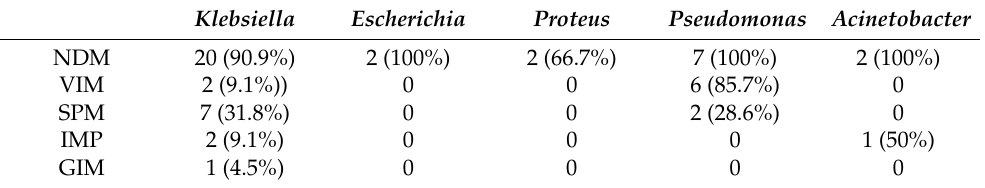
Table 6. Association between resistance genes and meropenem resistant strains (regarding